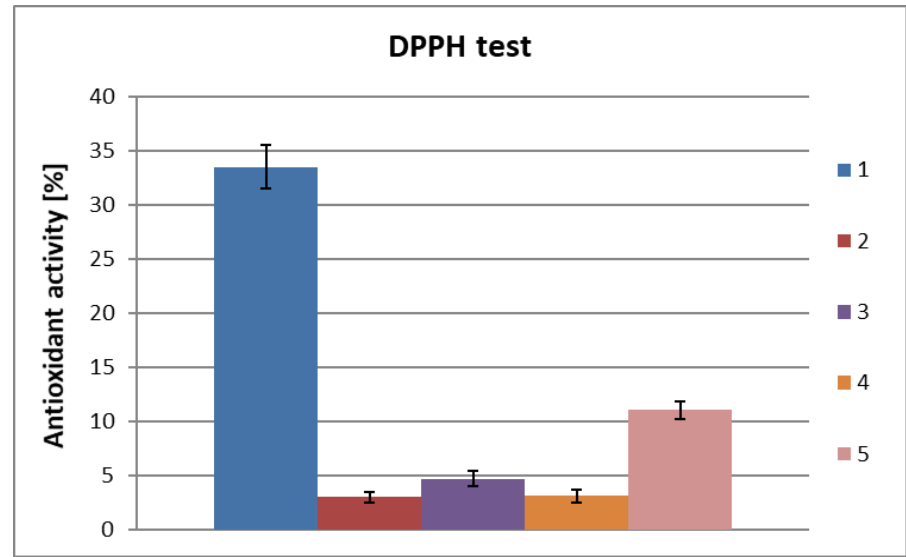
Figure 3. Total antioxidant activity of protein fractions obtained after treatment of aqueous biomass extract of Chlorella vulgaris with TCA separated by ultrafiltration: ( 1 ) ascorbic acid 1 nM (0.17 mg/mL); ( 2 ) protein fraction before separation (obtained by precipitation by TCA and a single centrifugation), c = 0.5 mg/mL; ( 3 ) protein filtrate after ultrafiltration on a 50 kDa filter, c = 2 mg/mL; ( 4 ) protein filtrate after ultrafiltration on a 10 kDa filter, c = 2 mg/mL; ( 5 ) protein filtrate after ultrafiltration on a 5 kDa filter, c = 1 mg/mL.